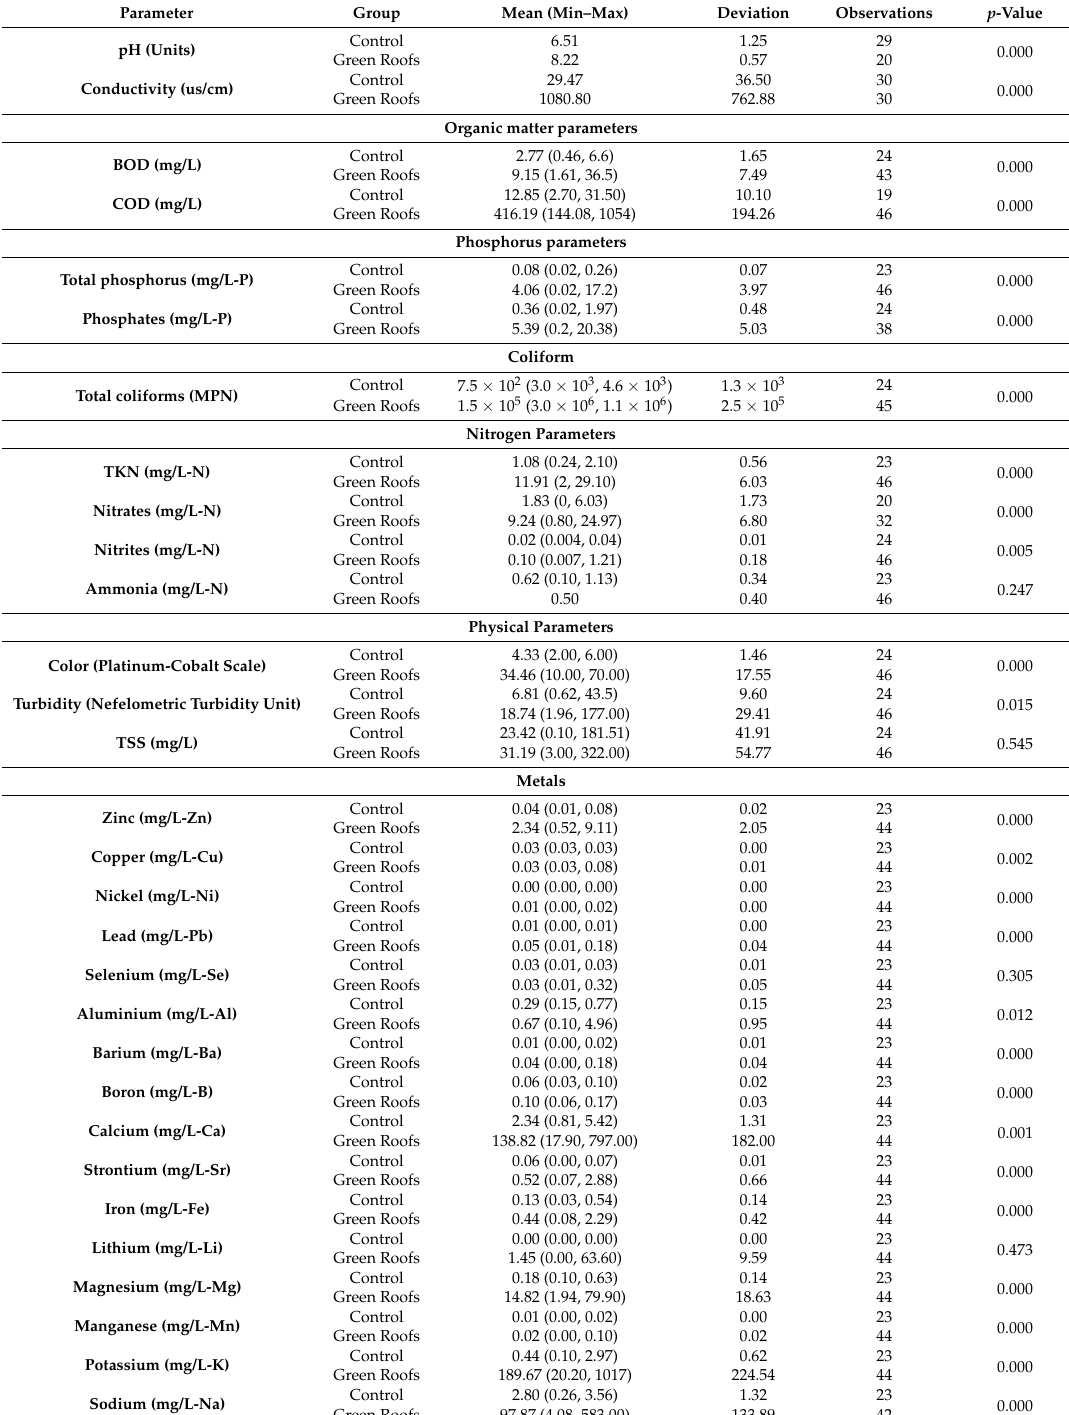
Table 3. Descriptive statistics and t -test results for the effect of green roofs on water quality